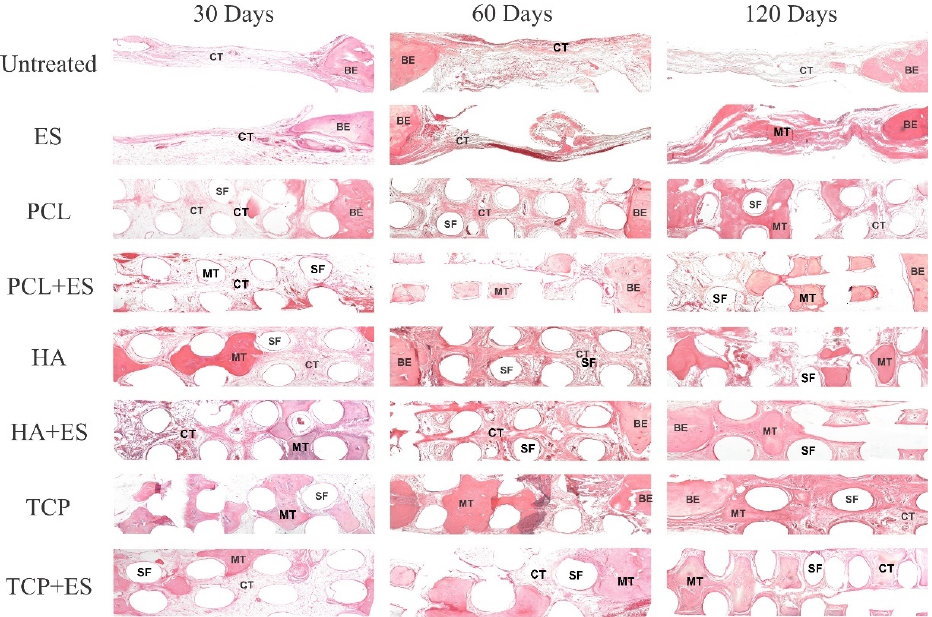
Figure 3. Hematoxylin ‐ eosin (HE) cross ‐ section images of bone tissue regeneration. Tissue formation is shown among the scaffold filaments and into the bone defect after 30, 60, and 120 d of the bone regeneration process. The image shows the bone edge (BE), connective tissue (CT), mineralized tissue (MT), and the scaffold filaments (SF). Figure 4a present the quantification of blood vessels in a 10 4 μ m 2 histological image area for all histological images stained with Masson’s trichrome. On day 30, the PCL/ES group presented an overall higher number of blood vessels compared to the other groups.